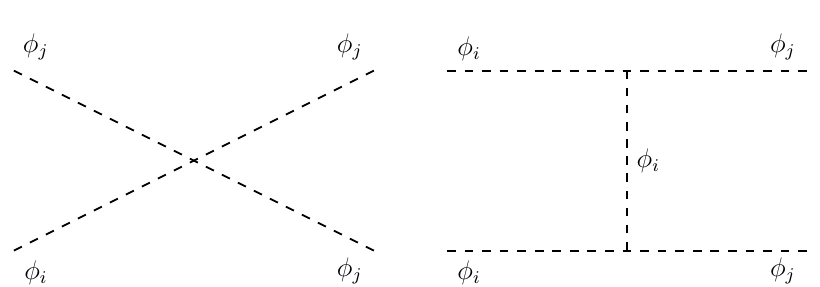
Figure 10 . (cid:30) i (cid:30) i $ (cid:30) j (cid:30) j DM conversion channels.